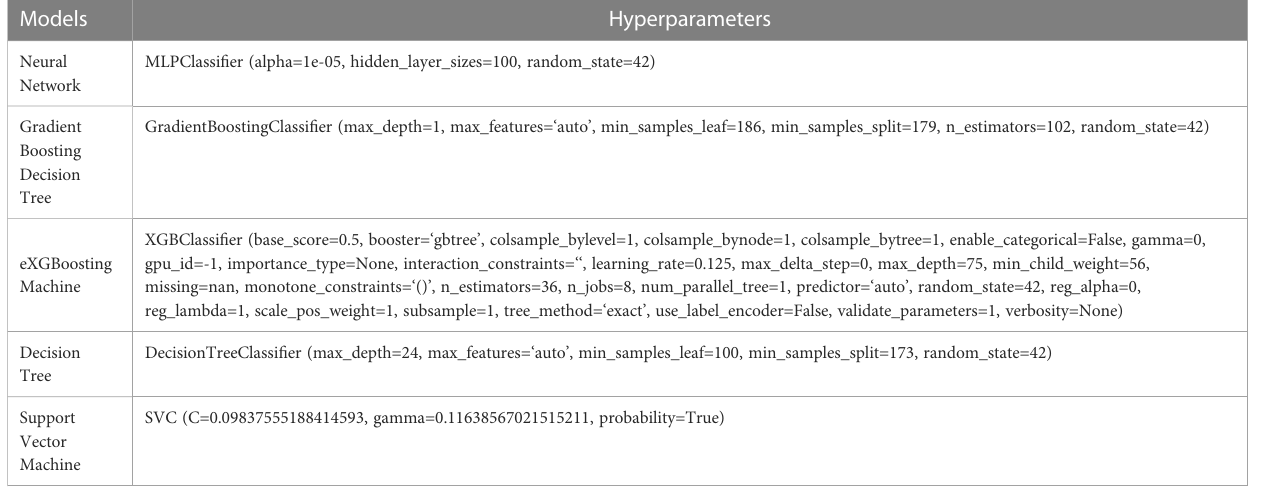
TABLE 4 Models and their hyperparameters.